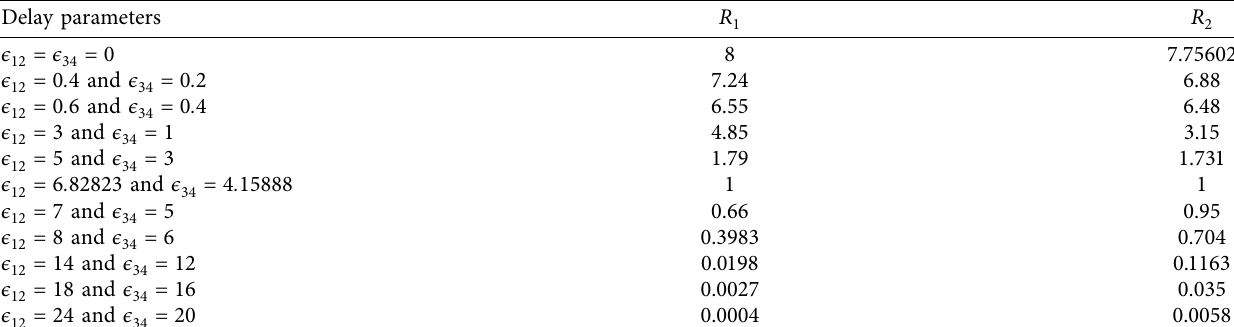
and R with respect to the delay parameters. 1 2